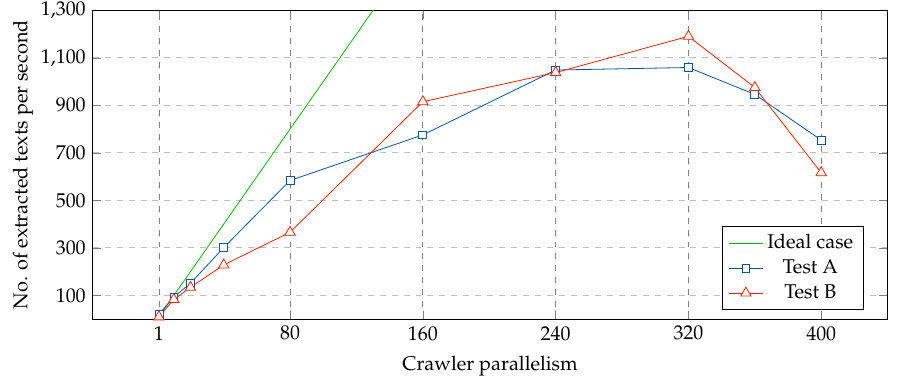
Figure 9. Performance of the crawler with varying parallelism settings (one